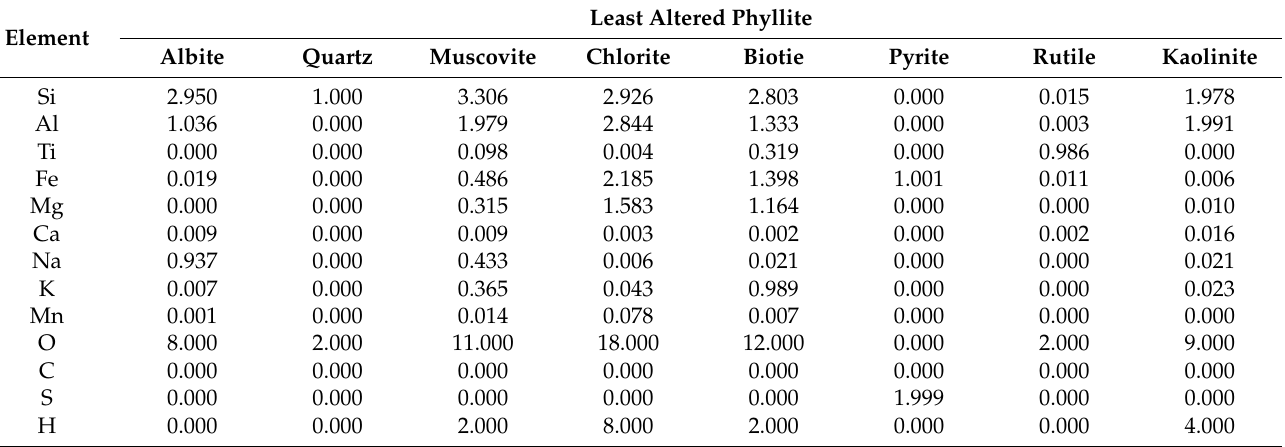
Table 3. Mineral formulae calculated from electron microprobe analysis used for the balanced mineral reactions of least altered